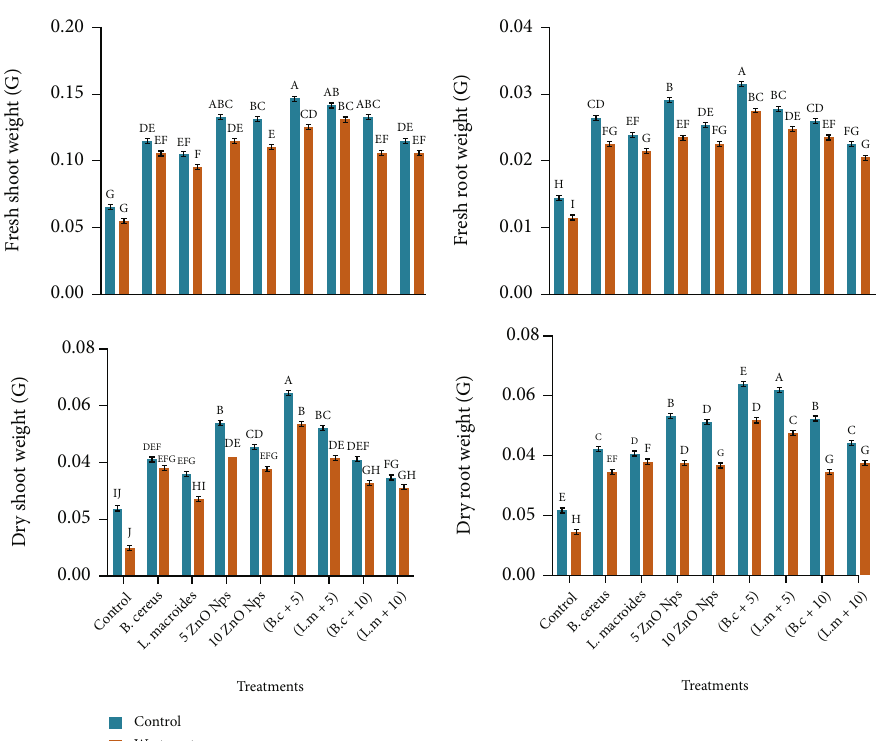
Figure 3: Synergistic e ff ect of bacteria strains ( Bacillus cereus and Lysinibacillus macroides ) and ZnO NP (5 mg/L and 10 mg/L) treatments on (a) fresh shoot weight (FSW), (b) fresh root weight (FRW), (c) dry shoot weight (DSW), and (d) dry root weight of rice grown in heavy metal-contaminated water. Error bars showed means of standard error ( ± SE) of three replicates ( n = 3 ) followed by di ff erent alphabetic letters showing statistical signi fi cance at 5% probability. Control (distilled water), B.C+5 ( Bacillus cereus +5mg/L ZnO NPs), L.M+5 ( Lysinibacillus macroides +5mg/L ZnO NPs), B.C+10 ( Bacillus cereus +10mg/L ZnO NPs), and L.M+10 ( Lysinibacillus macroides +10 mg/L ZnO